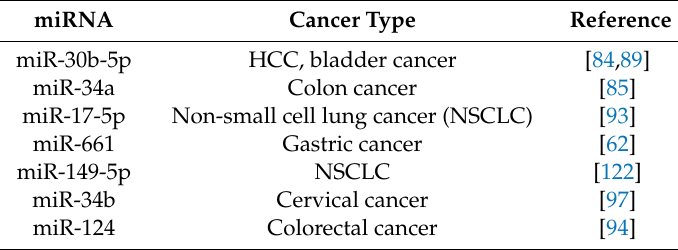
Table 3. Summary of miRNAs interacting with HNF1 α -AS1.